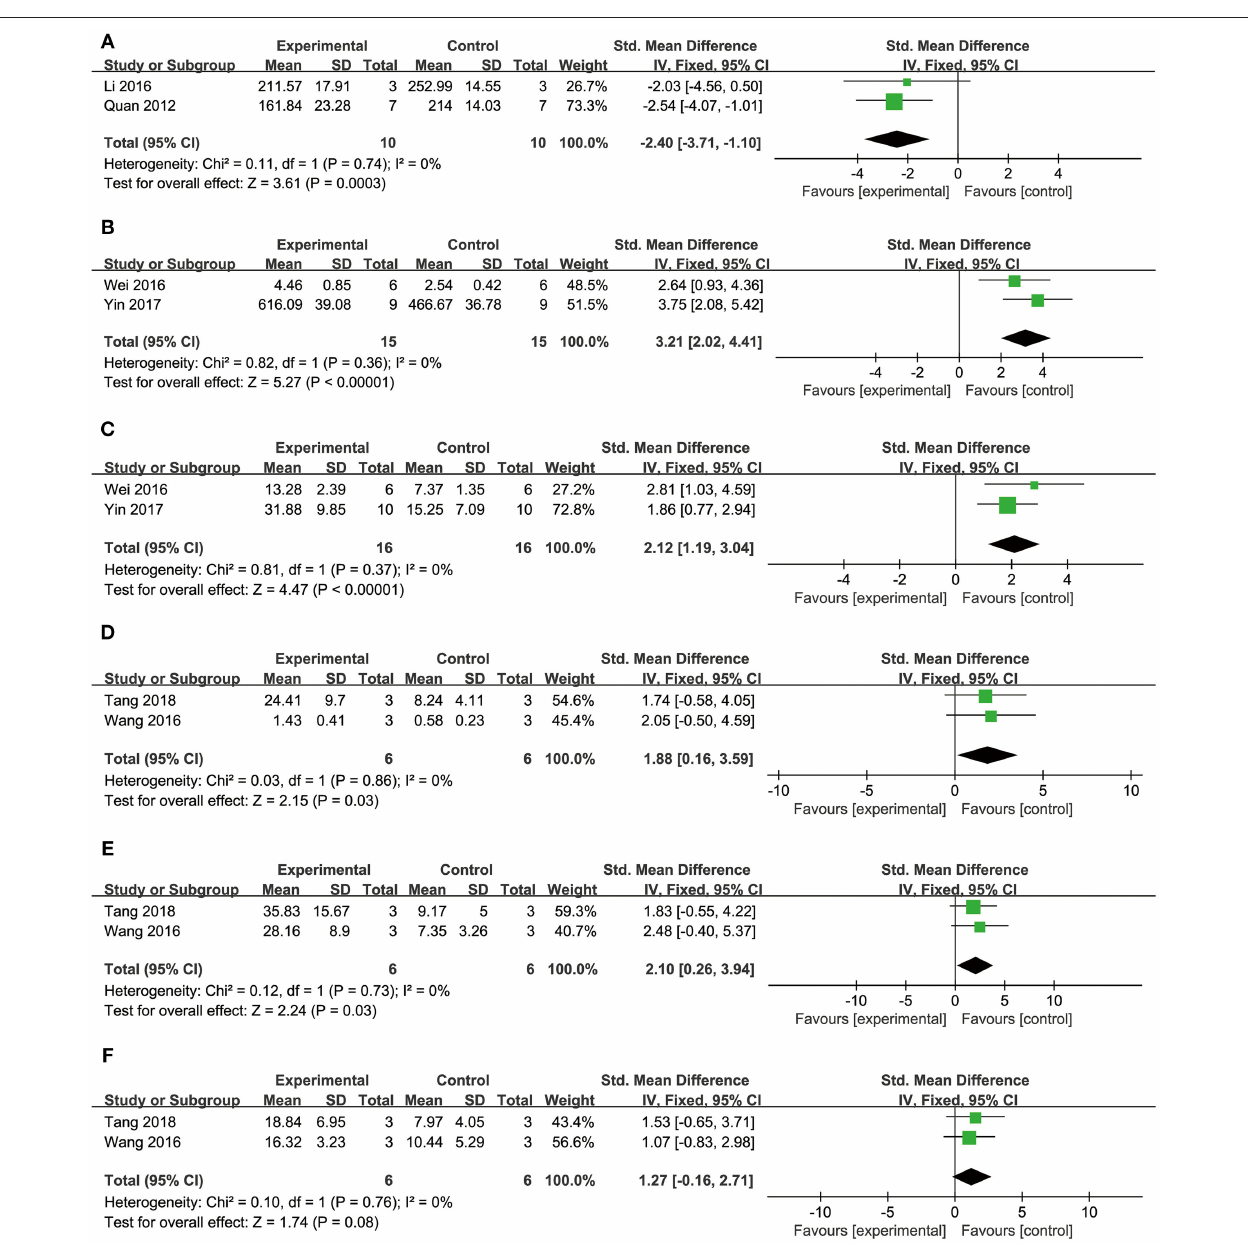
FIGURE 5 | The forest plot: (A) in vivo effects of danshensu for reducing TNF- α compared with controls ( n = 10 per group); (B) in vivo effects of danshensu for increasing SDF-1 compared with controls ( n = 15 per group); (C) in vivo effects of danshensu for increasing MVD compared with controls ( n = 16 per group); (D) in vivo effects of danshensu for increasing stroke volume compared with controls ( n = 6 per group); (E) in vivo effects of danshensu for increasing cardiac output compared with controls ( n = 6 per group); (F) in vivo effects of danshensu for increasing fractional shortening compared with controls ( n = 6 per group). TNF- α , tumor necrosis factor- α ; SDF-1, stromal cell-derived factor-1 α ; MVD, micro vessel density.